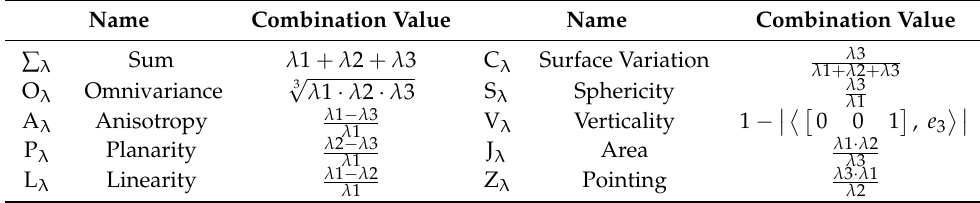
Table 1. Feature